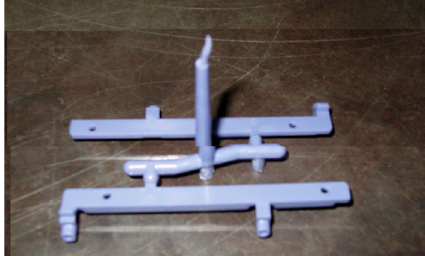
Figure 11: The actual thin-walled part by thin-wall injection